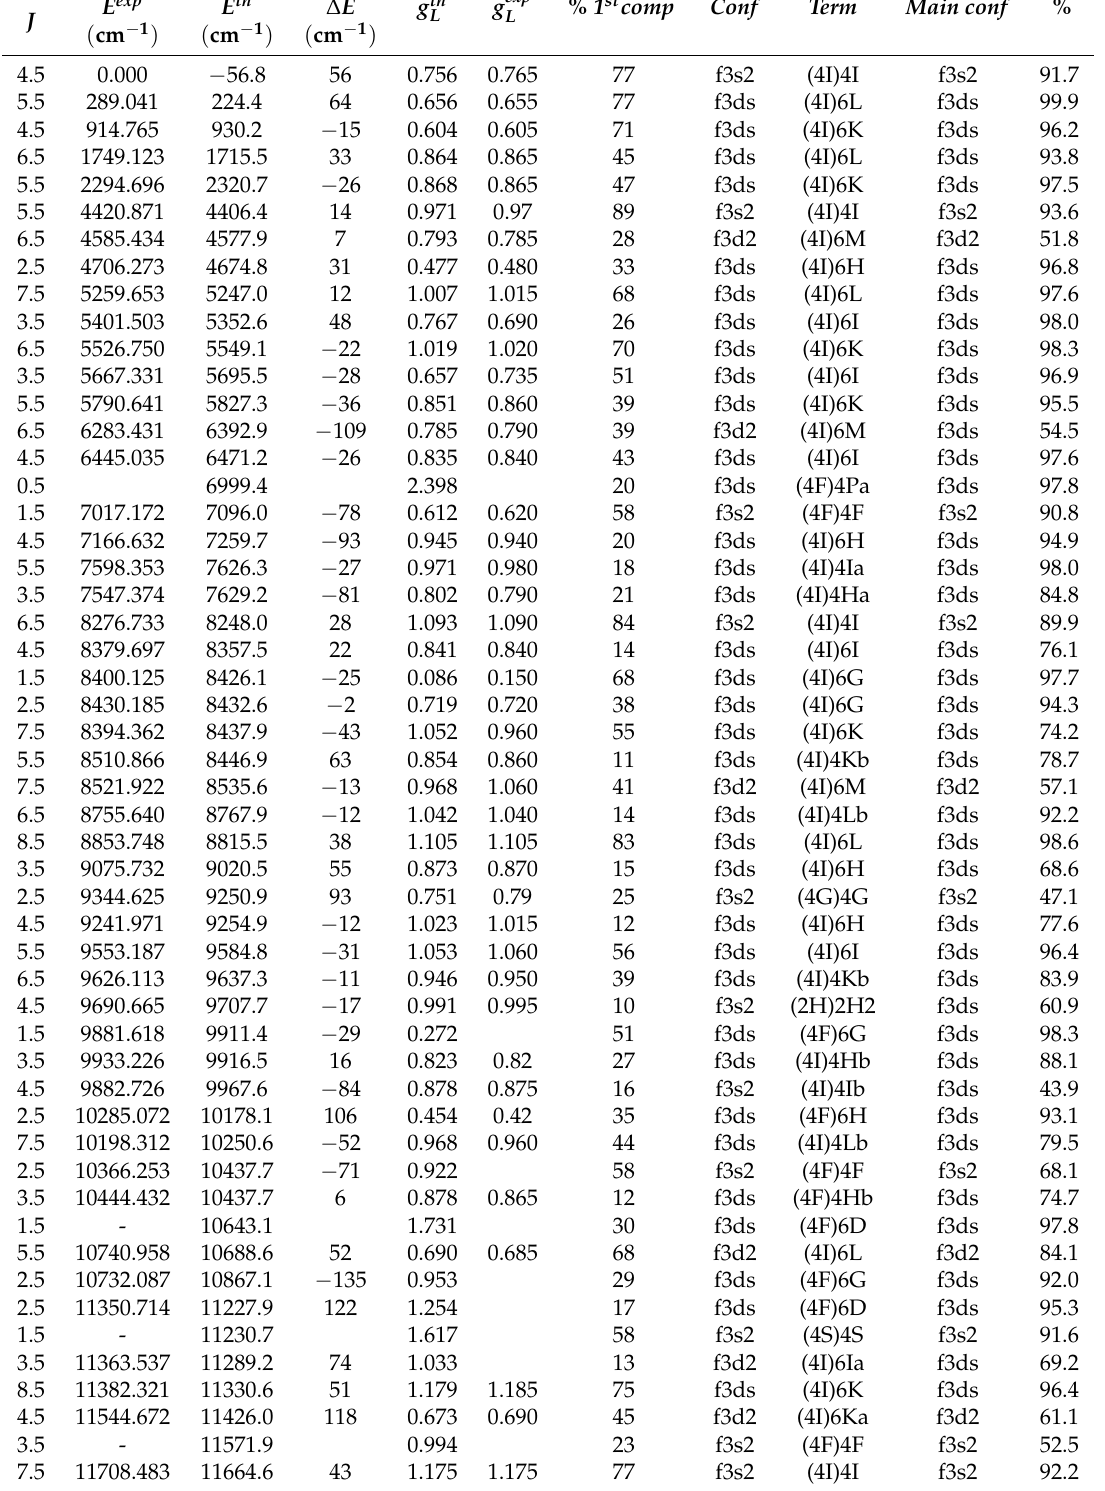
Table 3. Energy levels of U II, odd parity. Comparison of experimental energies and Landé factors with values calculated from the parameter set of Table 2. ∆ E = E exp - E th . The percentage of the leading term (notations from Cowan codes) and its configuration are specified by columns 7–9. The dominant configuration and its percentage are reported in the last two